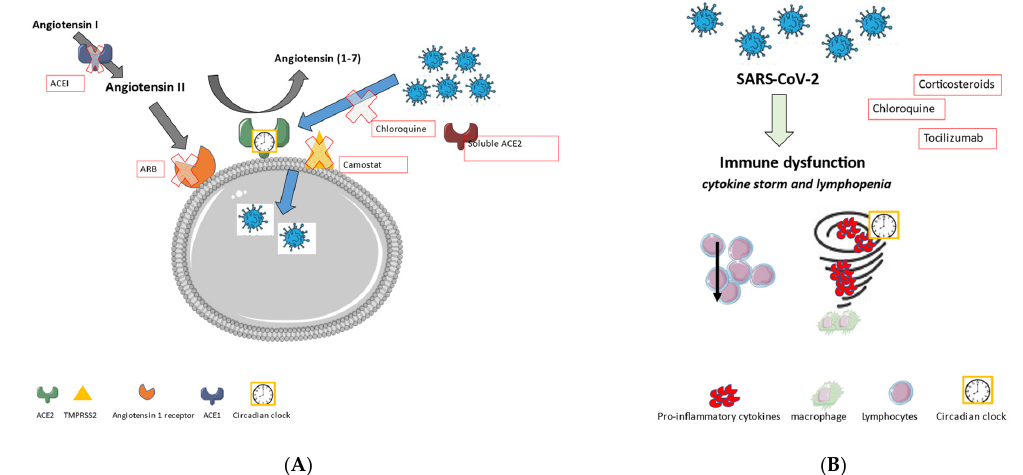
Figure 4. ( A ) The renin-angiotensin system (RAS) and its involvement in SARS-CoV-2 entry into the cells. In the red boxes, the possible treatments of a SARS-CoV-2 infection involving the RAS can be found. ( B ) The immune system and its involvement in a SARS-CoV-2 infection. In the red boxes, the possible treatments of a SARS-CoV-2 infection involving the immune system can be found.